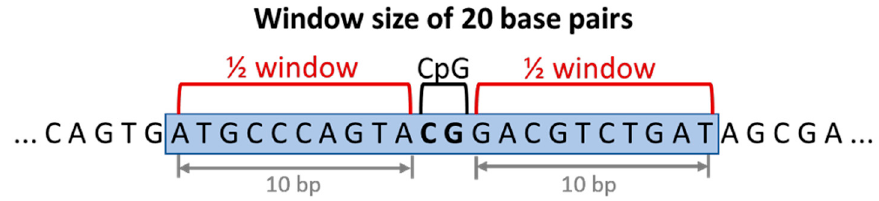
Figure 2. Creation of windows around CpG coordinates.